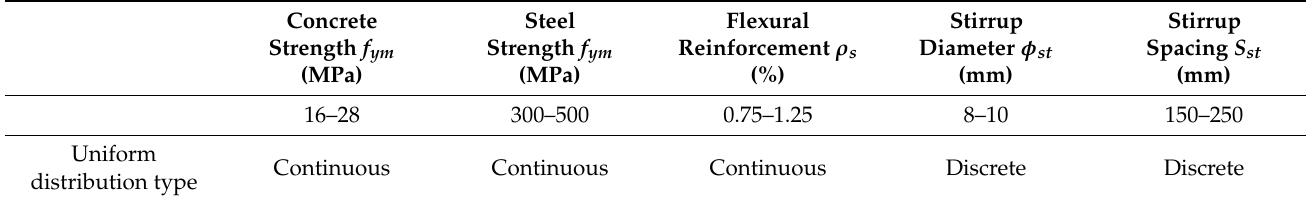
Table 3. Ranges adopted for material strengths, and for shear and flexural